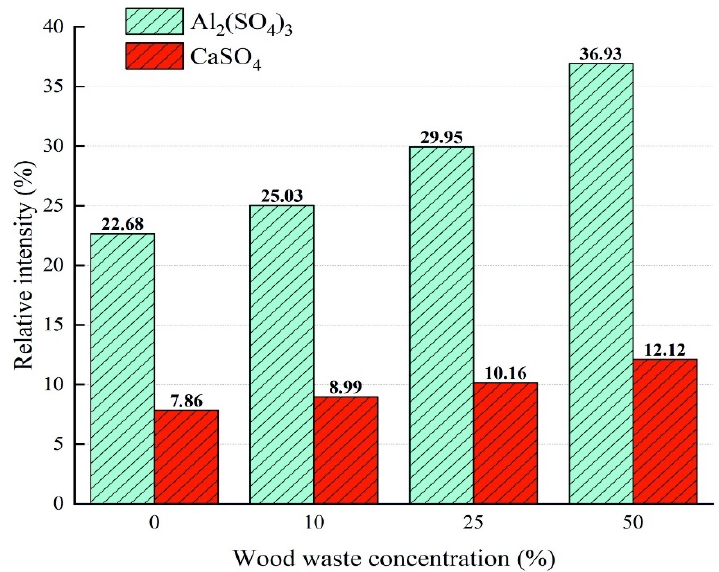
Figure 12. Changes in the content of calcium and aluminum sulfates in the ash of fuel mixtures based on lean coal and wood with an increase in the proportion of wood in the initial mixture during pyrolysis in an inert medium at T = 873